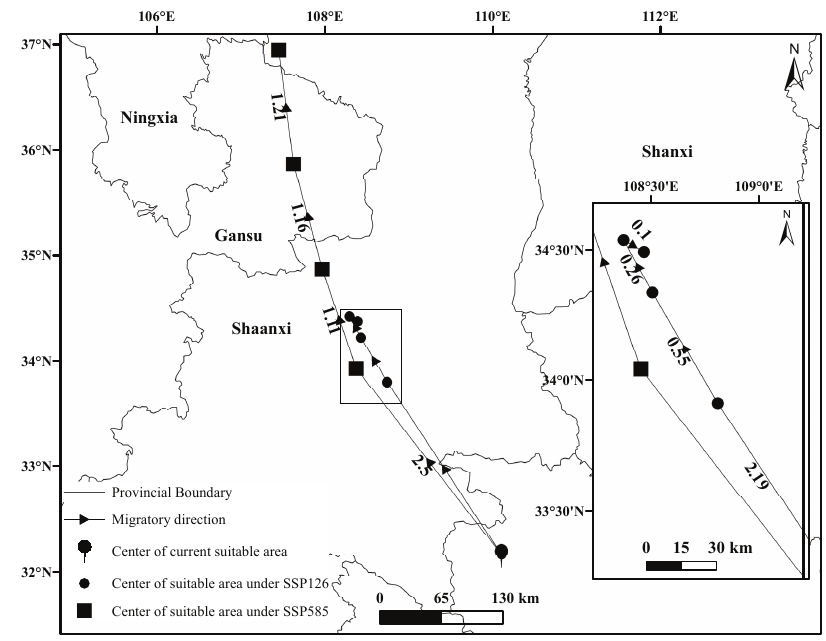
Figure 6. The migratory direction and distance of the average center at four periods ( × 10 5 m).